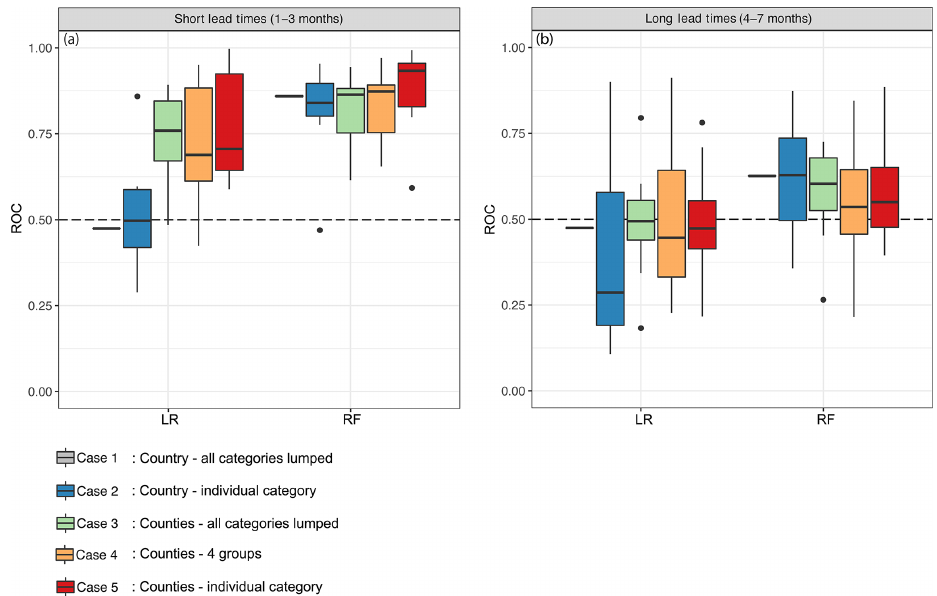
Figure 4. Skill of re-forecast drought impacts for the five cases using logistic regression and random forest approaches for the period 2002– 2010. The boxes indicate the spread of ROC values for drought impact functions (15 ensemble members) for (a) short lead times (1–3 months) and (b) long lead times (4–7 months). The black dashed line indicates the threshold. All values below this line show that the models have no discriminative capacity to distinguish impact and no impact. The dots stand for models